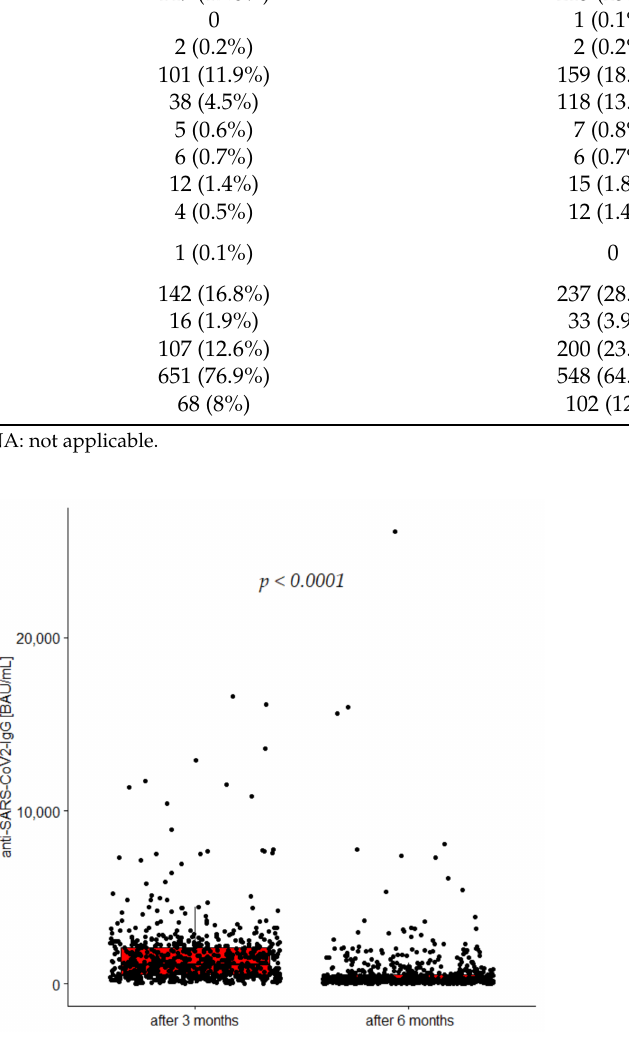
Figure 2. Anti-SARS-CoV-2 IgG concentrations 3 and 6 months after